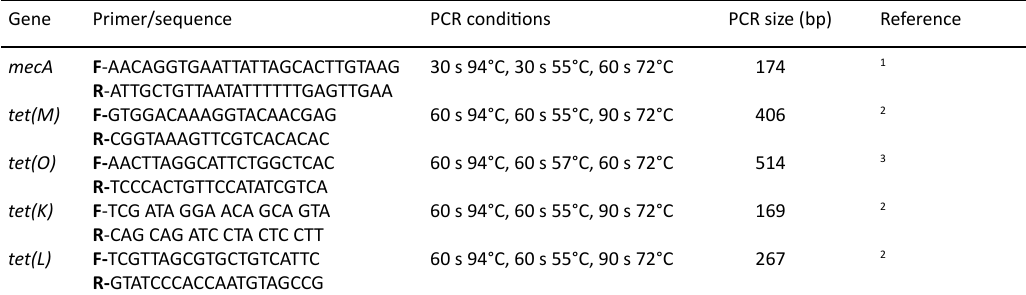
table s1. PCR primers and cycling parameters for genes presented in this study Gene Primer/sequence